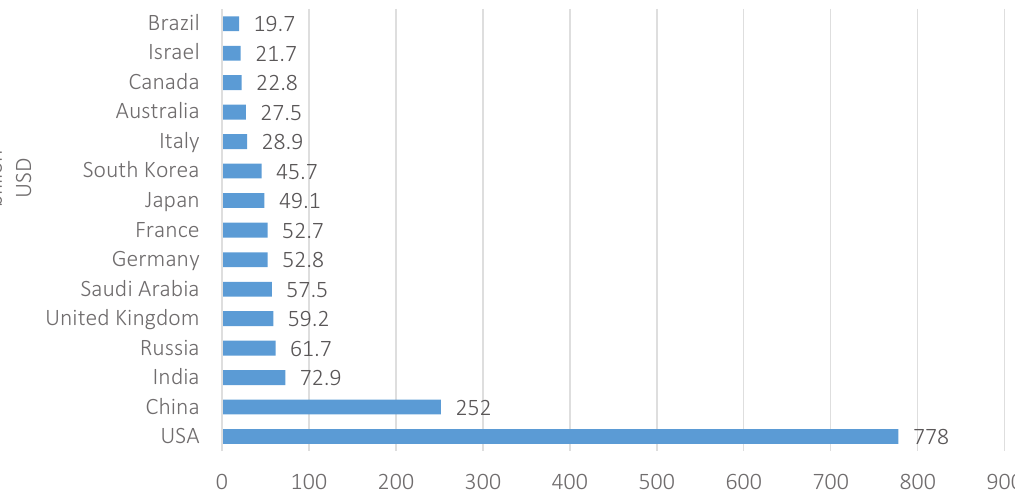
Figure 5. Countries with the highest military spending worldwide in 2020 (in billion